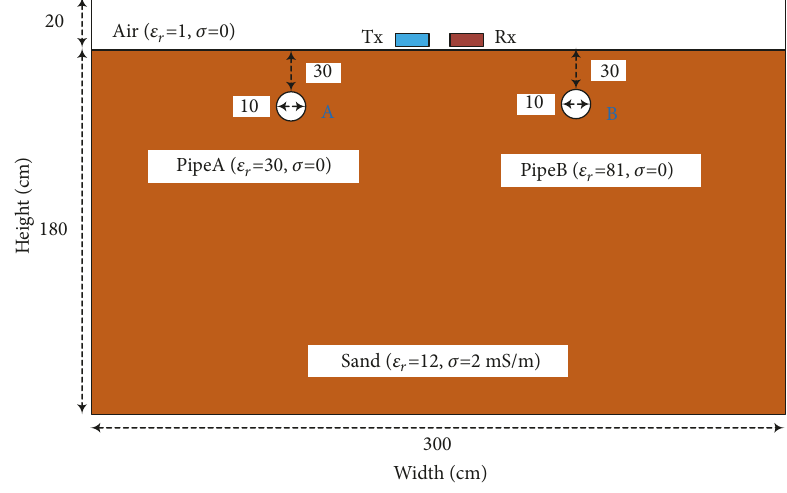
Figure 17: A sketch of the underground pipes model GPR model simulated in this